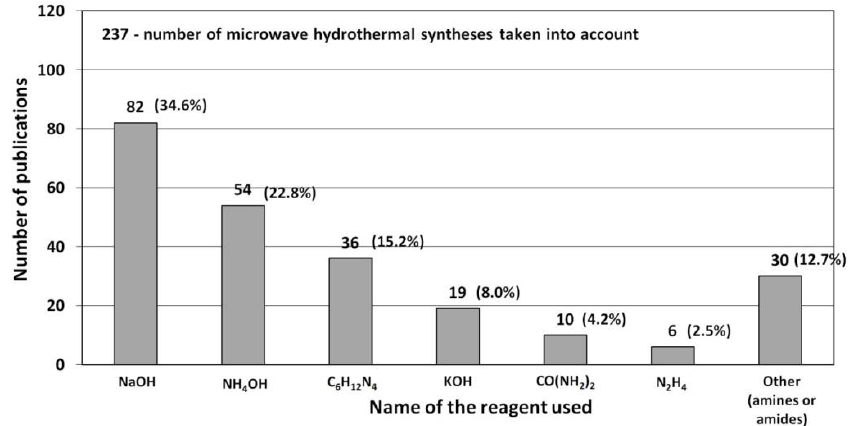
Figure 16. Statistics concerning the use of reactants (OH − ) in the microwave hydrothermal synthesis of ZnO. Source: [506–738].